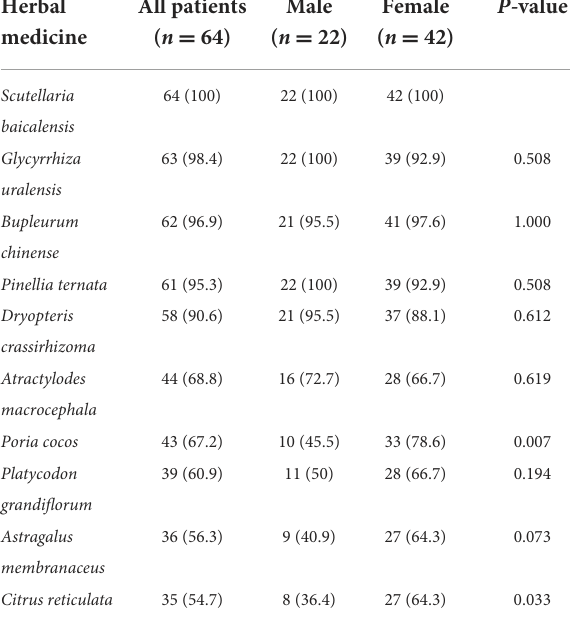
TABLE 6 Frequency of Chinese medicine using in patients whose PCR positive length and hospitalization length less than median (top 10). Herbal